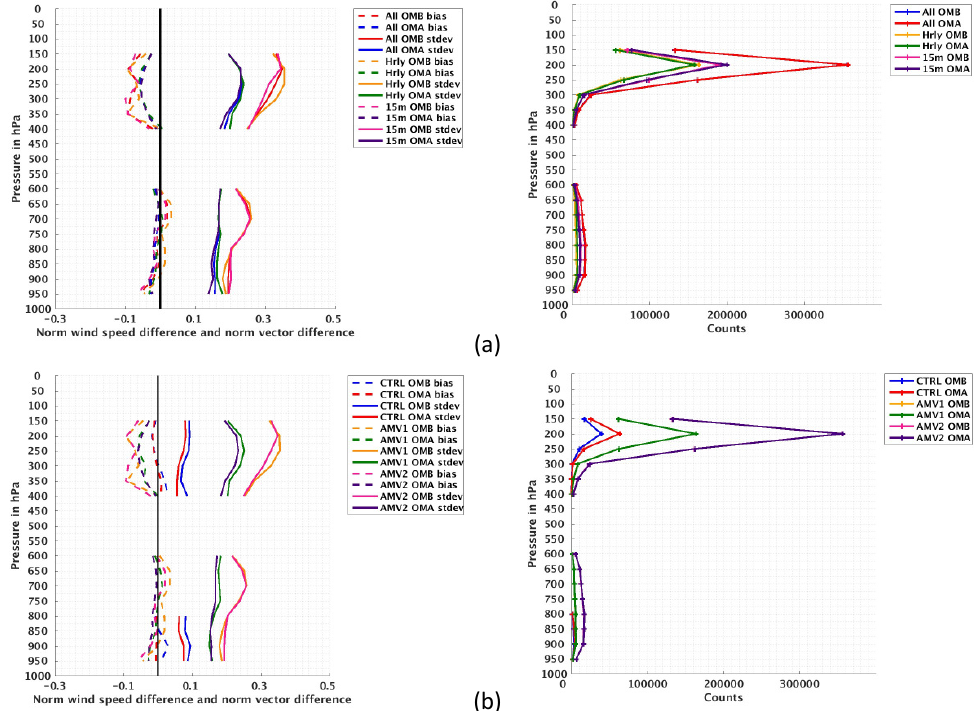
Figure 6. Impact on IR AMVs due to changes in QC procedures and error profile on (left) the mean AMV normalized speed departure from the background/analysis (dashed) and the standard deviation of the AMV normalized vector difference from the background/analysis (solid) binned at every 50 hPa and (right) the corresponding number of observations assimilated. Statistics are calculated from the entire life cycle of 2020 Tropical Storm Cristobal. ( a ) Statistics are derived from hourly and 15 min AMVs separately and ( b ) statistics for a different experiment. CTRL is the current setting used in the 2020 operational HWRF. AMV1 only assimilated hourly AMVs with new QCs and error profile. AMV2 assimilates both hourly and 15 min AMVs using new QCs and error profile.